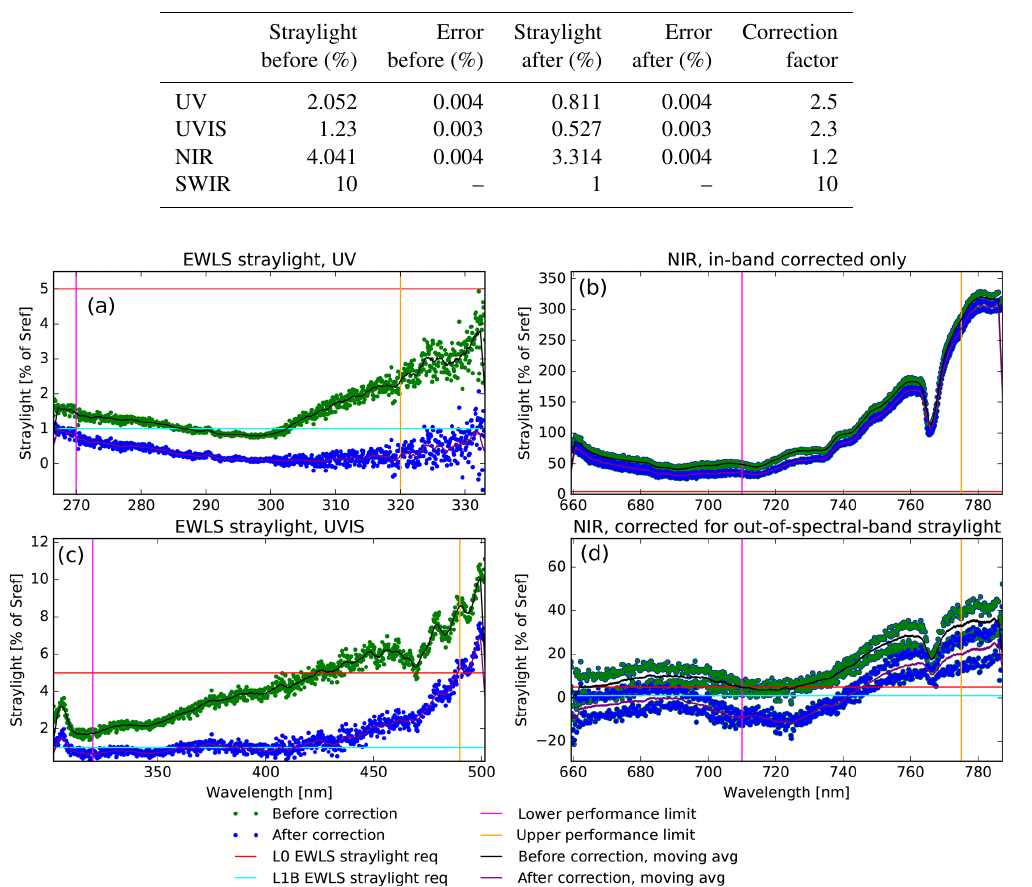
Table 8. Average straylight before and after the straylight correction together with the corresponding error estimates, as well as the average straylight correction factor. Listed is the total integrated (straylight) signal outside the direct region divided by the integrated signal inside the direct region. The values for UVN were obtained from EWLS measurement data via the Earth port. The error estimates for UVN are valid only if the systematic errors are negligible with respect to the random noise. The results shown for SWIR were obtained from laser measurements and are reproduced from Tol et al. (2018).